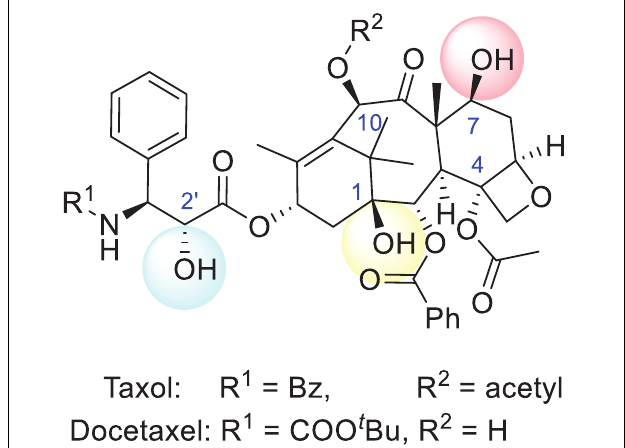
FIGURE 1 | The structures of Taxol and docetaxel. The R 1 group of Taxol (PTX) is Bz and the R 2 group is acetyl , while the R 1 group of docetaxel (DTX) is COO t Bu and the R 2 group is a hydrogen